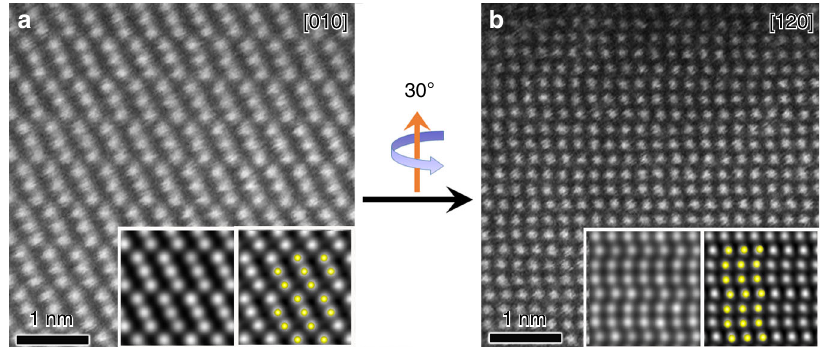
Fig. 3 Handedness determination of one Te crystal. STEM-ADF images of a Te crystal along a [010] and b [120] zone axes in a tilt-series (insets are simulated (left) and p 1 symmetry-averaged images (right) overlaid with structural models, with yellow spheres representing Te